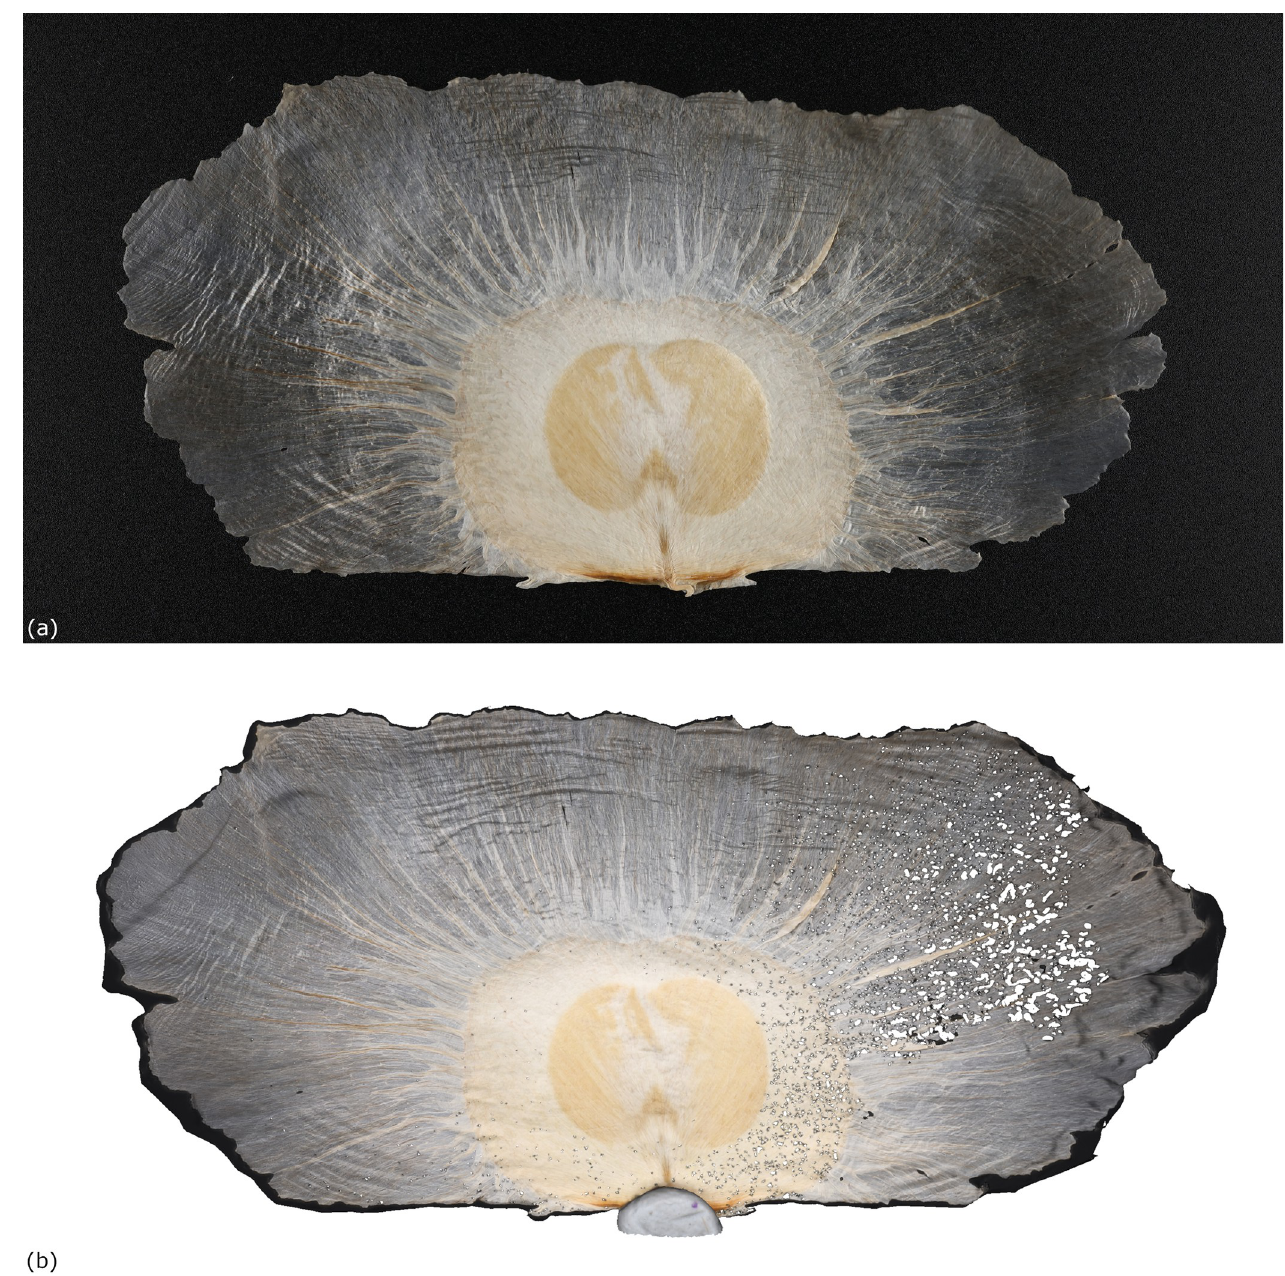
Fig 9. Reconstruction trials of carpological materials with transparency. (a) A seed of Oroxylum indicum (Linnaeus) Bentham ex Kurz. The background color passed through the transparent parts of the seed. (b) A 3D model of the same seed reconstructed with a black background. The transparent parts were stained with background